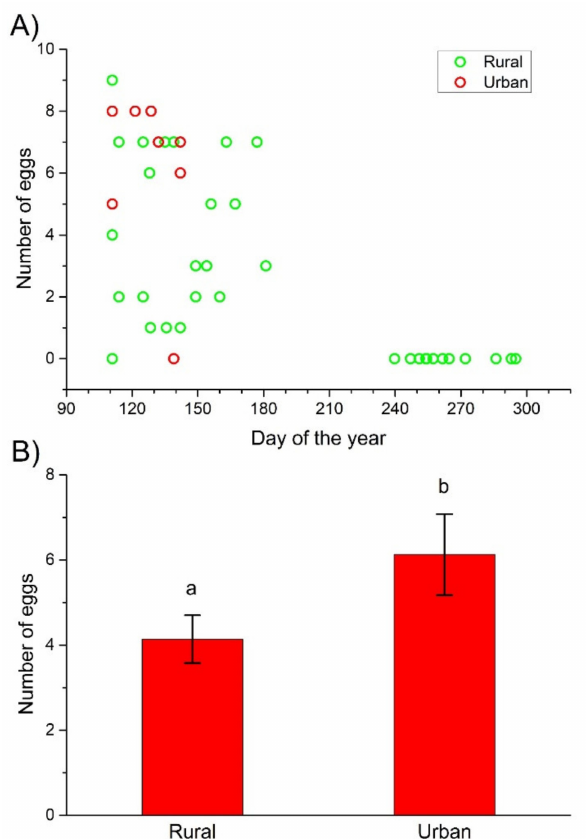
Figure 2. The number of ripe eggs in the ovaries of rural and urban C. convexus females during the days of the study year ( A ) and the mean number ( ± SE) of ripe eggs in the ovaries of females before oviposition trapped between April and June 2020 in the rural and urban habitats ( B ). Different letters indicate significant differences based on the LSD test ( p <